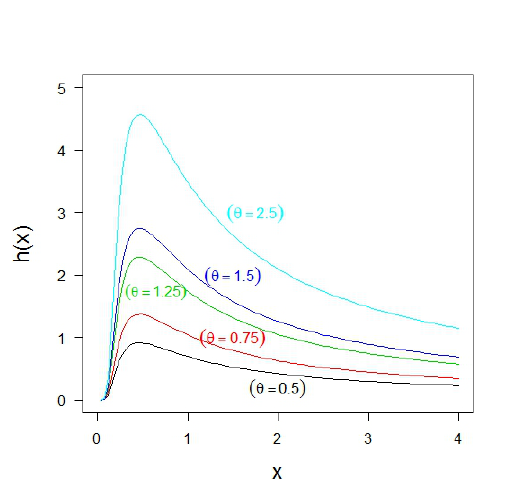
Figure 2 – Hazard function plot of IEGD for different values of θ